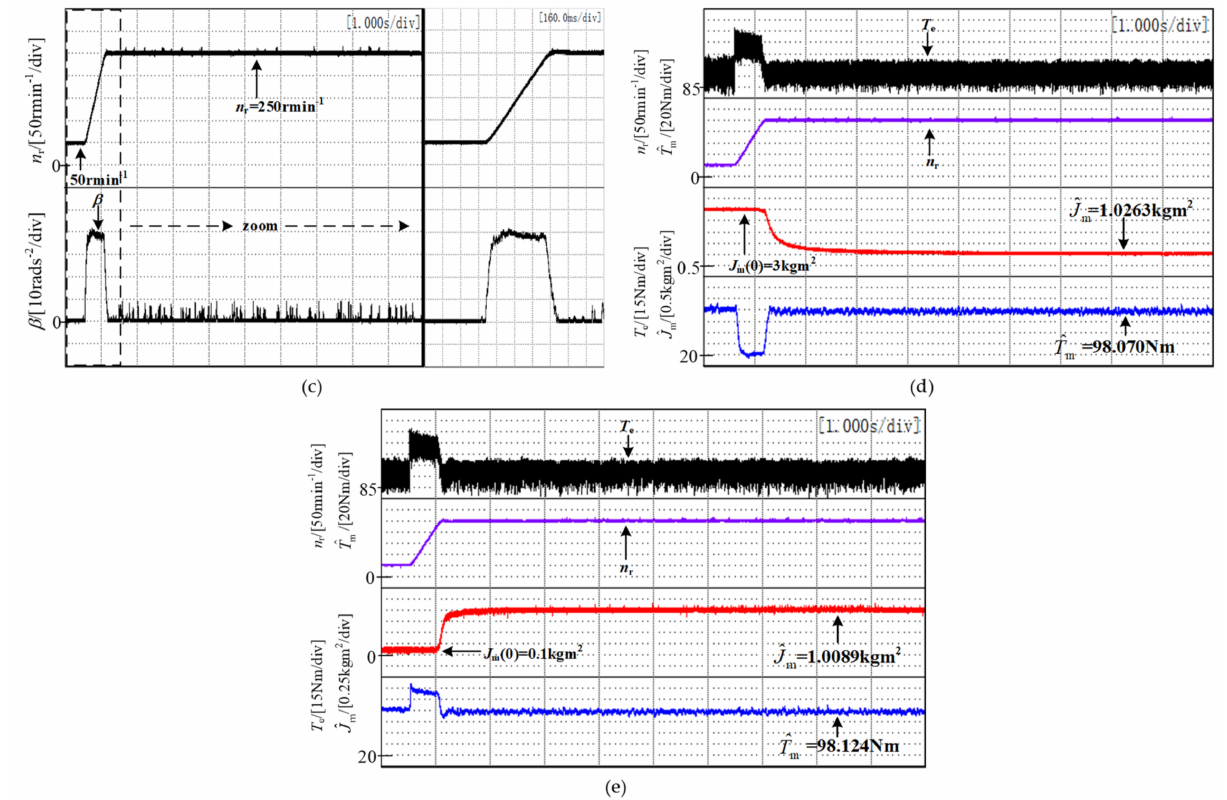
Figure 12. Experimental results with a load torque of 100 Nm: ( a ) Three phase current waveform; ( b ) Electromagnetic torque waveform; ( c ) Velocity and acceleration waveform; ( d ) Identification waveforms of moment of inertia and total load torque when J m (0) = 3 kg m 2 ; ( e ) Identification waveforms of moment of inertia and total load torque when J m (0) = 0.1 kg m